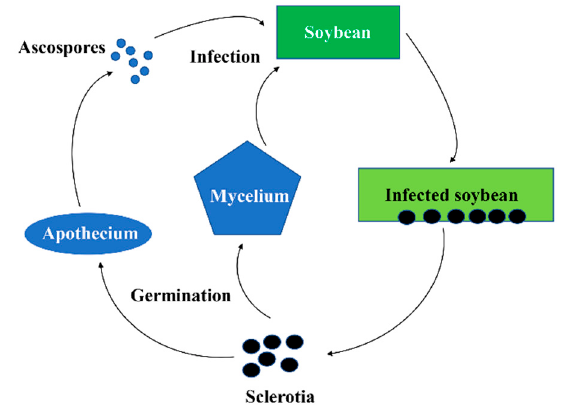
Figure 1. Infection cycle of Sclerotinia sclerotiorum .